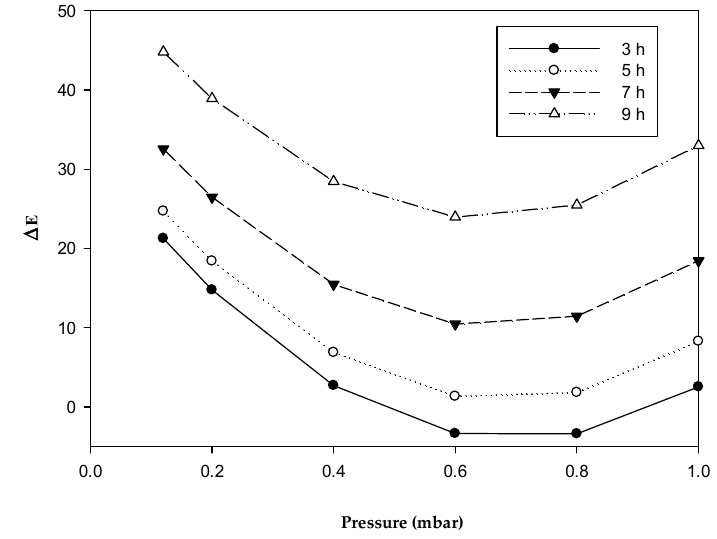
Figure 3. Predicted color difference ( Δ E) of dried MKG at different freezing times and pressures. 221